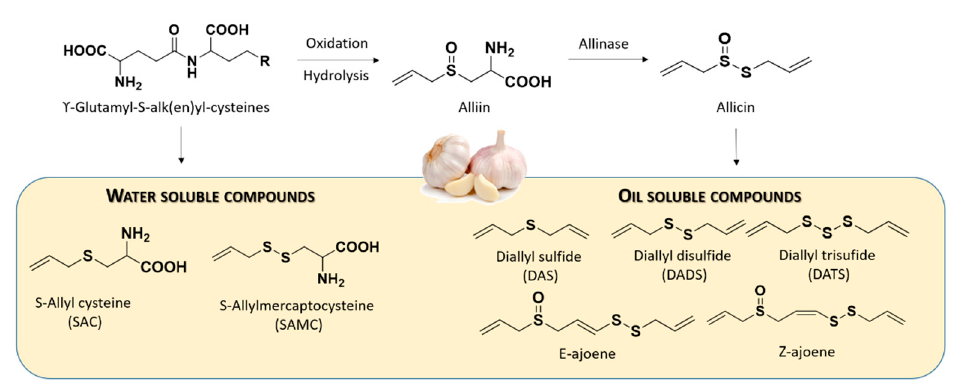
Figure 4. Chemical structures of commonly studied organosulfur compounds of garlic. SAC, a sulfur-containing amino acid, was considered an endogenous H 2 S-producing agent by providing the substrate for CSE in the H 2 S synthesis (Figure S1).